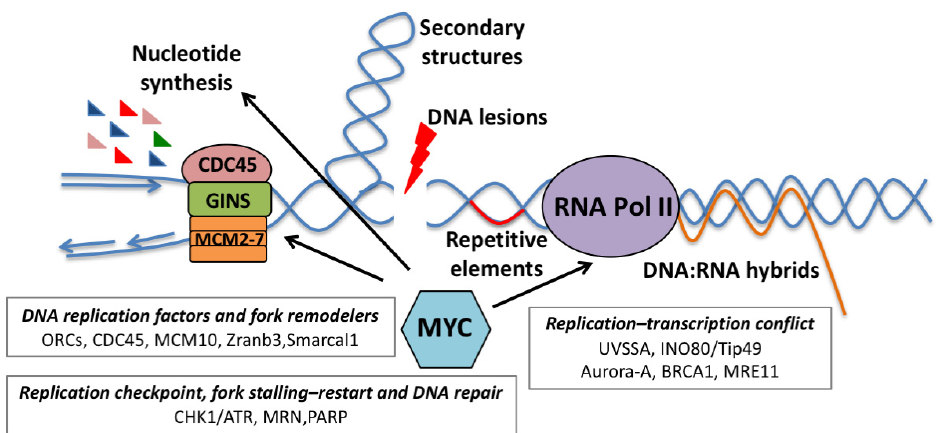
Figure 2. Schematic view of the most common mechanisms leading to replicative stress. Arrows are pointing to those events that are controlled by MYC and that can either support DNA replication or can predispose cells to replicative stress. Text boxes: details for the processes and the factors implicated in MYC-induced replicative stress.